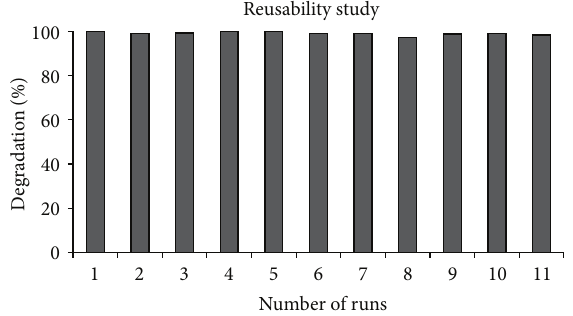
Figure 6: Reusability data over 2%Au/TiO 2 in the degradation of 50 mL of 10mg/L MO, over 3g/L catalyst, for 1h irradiation under